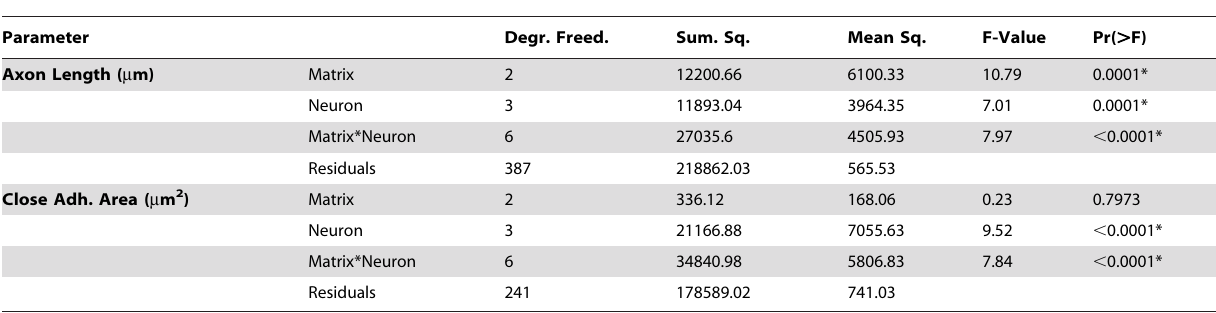
Table 4. GCs on Synthetic Matrices. ANOVA Values.